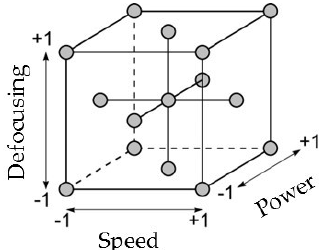
Figure 2. Face-centered central composite design scheme.